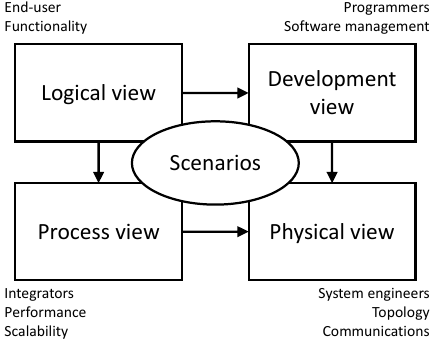
Figure 4. Kruchten 4 + 1 framework [22].